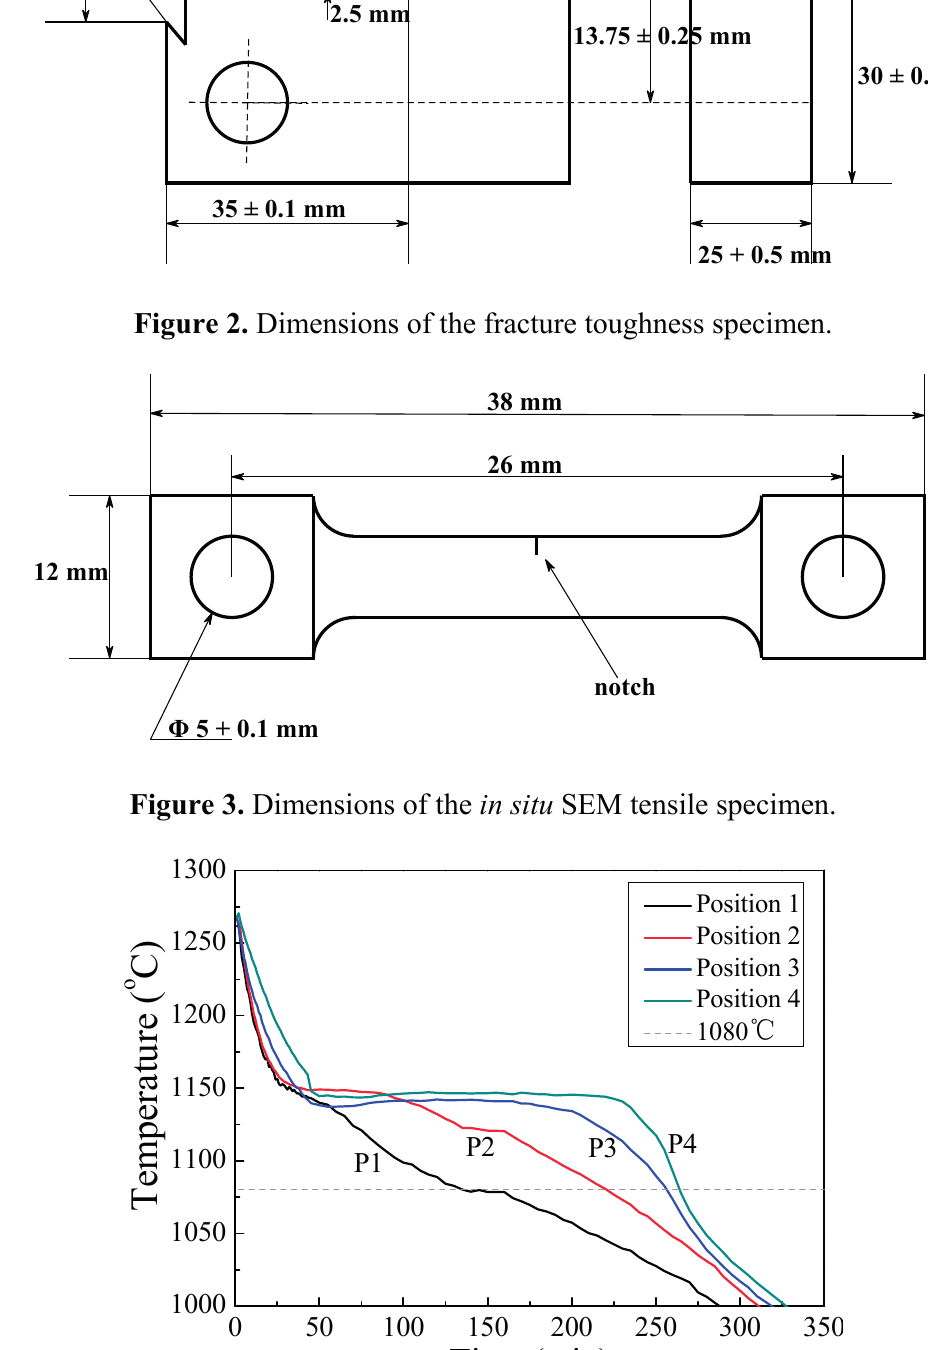
Figure 4. Cooling curves at four positions of castings during